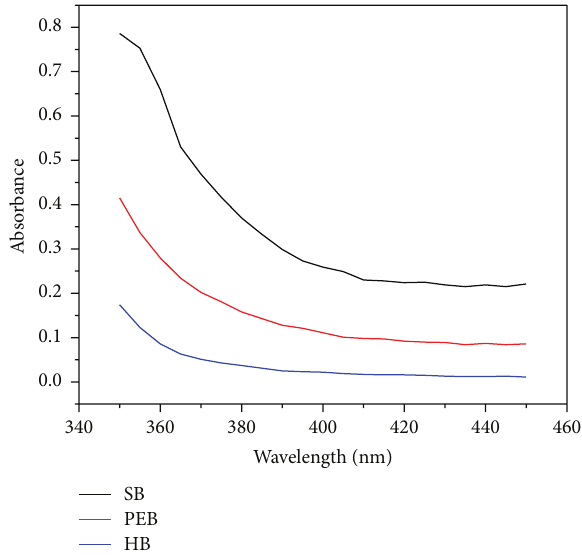
Figure 2: UV-visible absorption spectra of bilayer samples formed by deposition of Microposit over different thermally treated SU-8 2010 films after development of Microposit